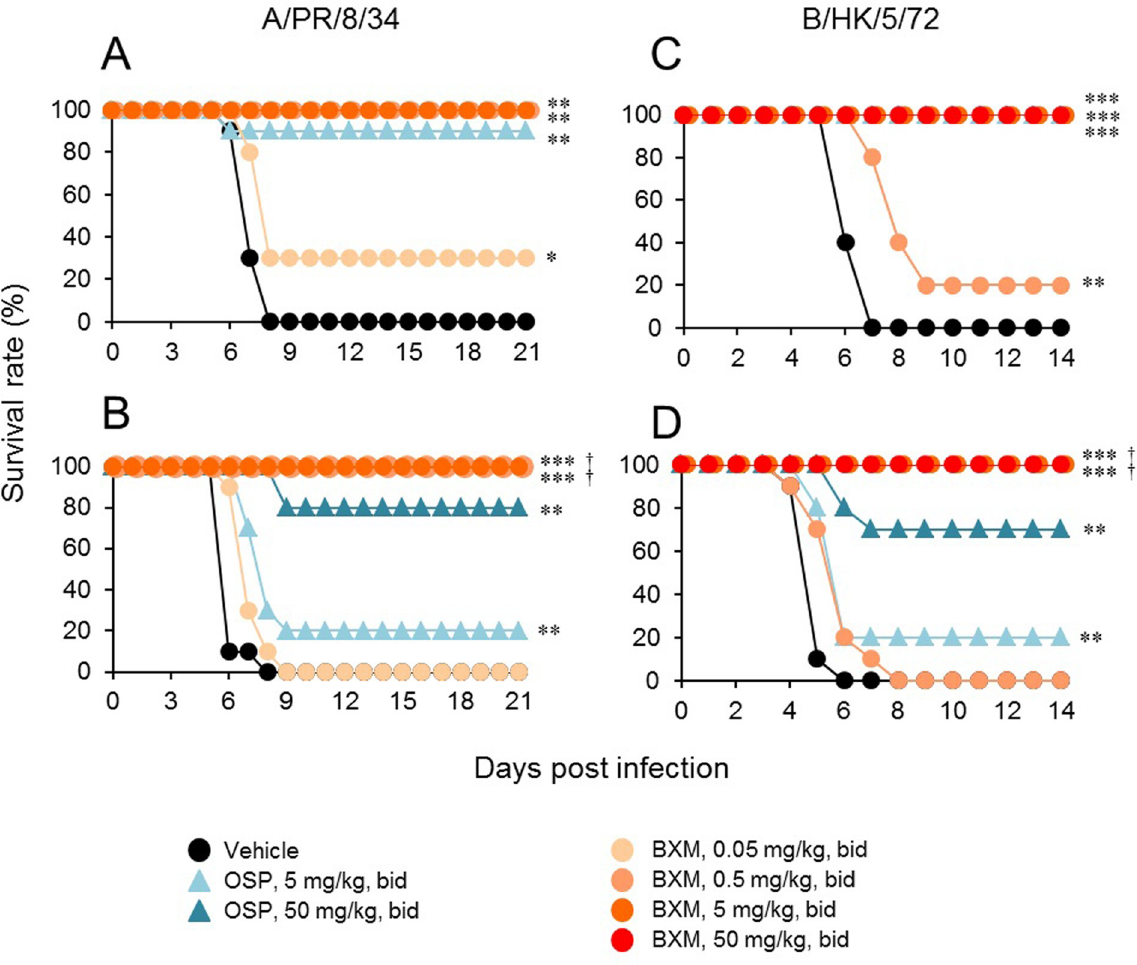
Fig 1. Therapeutic efficacy of single-day oral administration of BXM in a lethal infection mouse model. Nine to ten mice per group were intranasally infected with (A) 1.38 × 10 3 or (B) 4.42 × 10 4 TCID 50 virus suspension of A/PR/8/34, or (C) 3.30 × 10 5 or (D) 1.98 × 10 6 TCID 50 virus suspension of B/HK/5/72 and then orally administered BXM (0.05, 0.5, 5, or 50 mg/kg) bid for 1 day, OSP (5 or 50 mg/kg) bid for 5 days, or vehicle bid for 1 day. Mice were examined daily for survival through 14 or 21 days p.i.. The survival time in groups treated with BXM for 1 day was significantly prolonged compared to those in the vehicle-treated group ( � , P < 0.05; �� , P < 0.001; ��� , P < 0.001) or OSP (5 mg/kg bid)- treated group ( † , P <